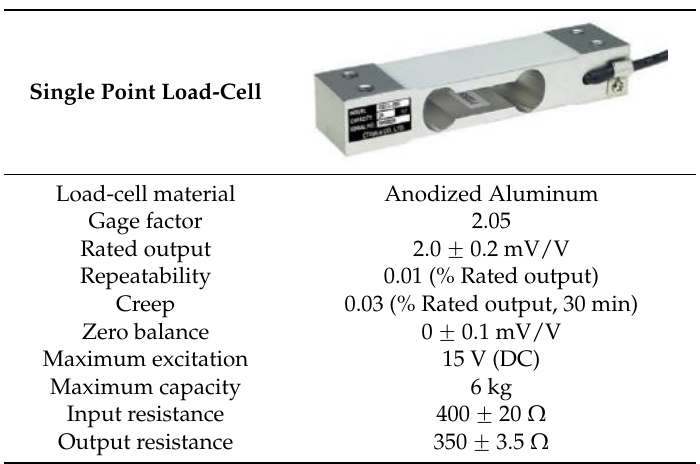
Table 1. Technical specifications of load-cell sensor.